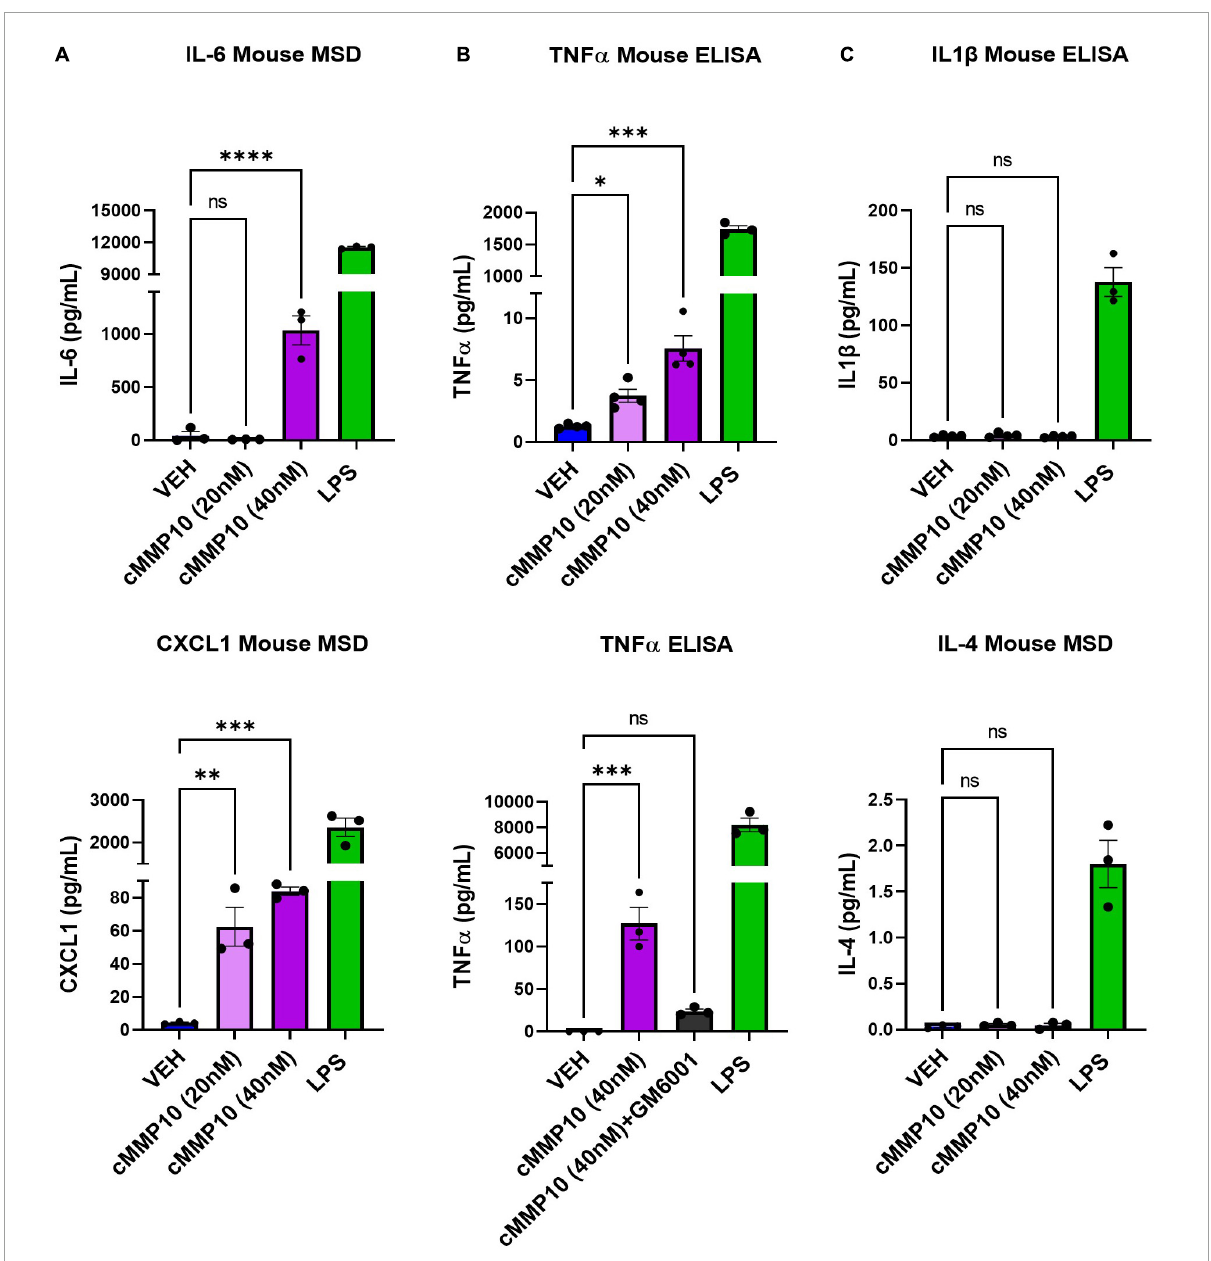
FIGURE4 The release of classical proinflammatory cytokines is increased in cMMP10-stimulated microglia. Microglia were exposed to cMMP10 (20 or 40 nM) or vehicle (VEH) for 24 h. (A) Cells stimulated with 40 nM cMMP10, but not 20 nM cMMP10, significantly increase IL-6. These cells also release CXCL1 release in a dose responsive manner to cMMP10. (B) cMMP10-exposed microglia demonstrate higher levels of TNF α in a dose responsive manner compared to VEH treated cells (ELISA; n = 4 wells/treatment). (B) The increase of TNF α following cMMP10 exposure